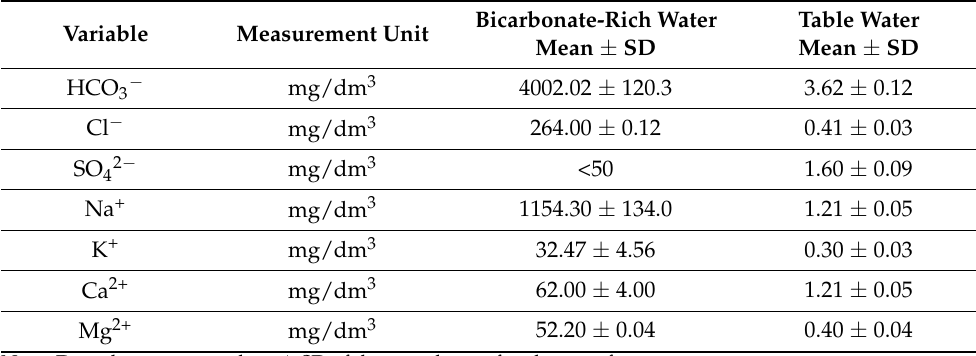
Table 2. Chemical properties of water used in the study.